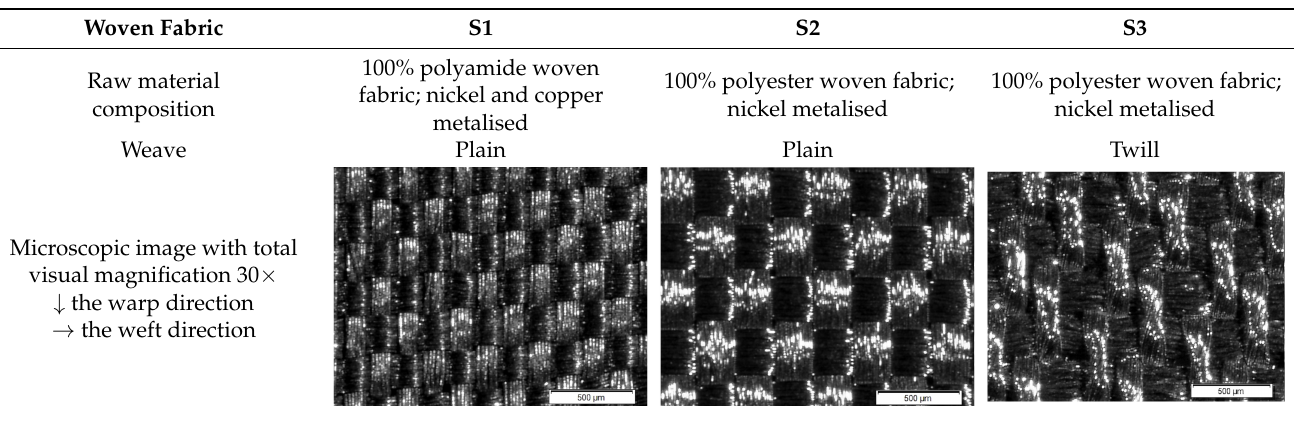
Table 1. The raw material composition of woven fabrics.